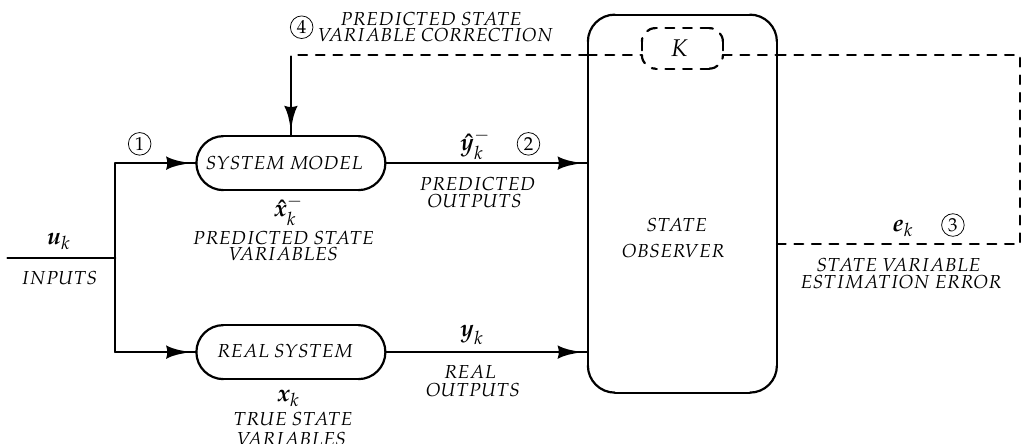
Figure 1. The operating principle of the EKF.